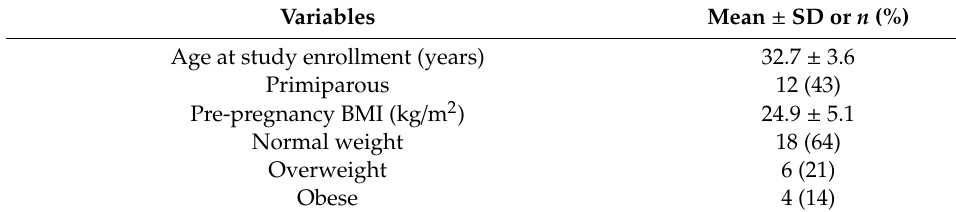
Table 1. Participants’ characteristics ( n =